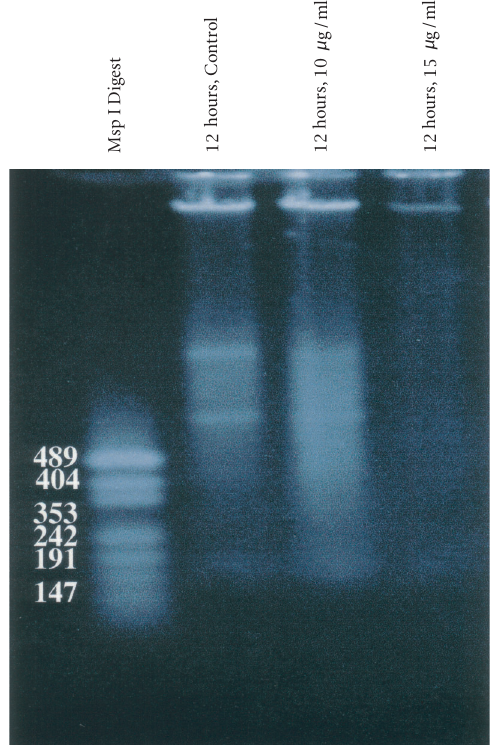
Figure 7: Agarose gel (0.8%) of DNA extracted from BB-88 cells: Lane 1, KB Ladder; Lane 2, Control ( 12 hours); Lane 3, tamox- ifen treatment ( 12 hours, 10 µ g/ml); Lane 4, tamoxifen treatment ( 12 hours, 15 µ g/ml). Only a faint DNA smearing is visible in the 15 µ g/ml treatment